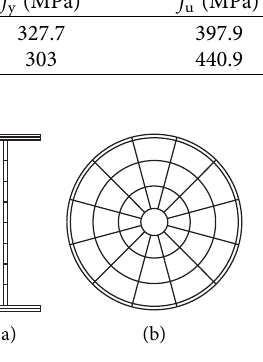
Figure 2: Fiber model of sections. (a) Beam. (b) CFCST column.